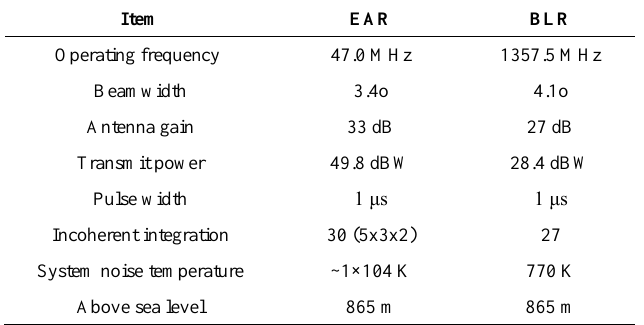
Table 1. Specification of the EAR and BLR by system as major parameters of radars used for dual-frequency algorithm Item EAR BLR Operating frequency 47.0 MHz 1357.5 MHz Beamwidth